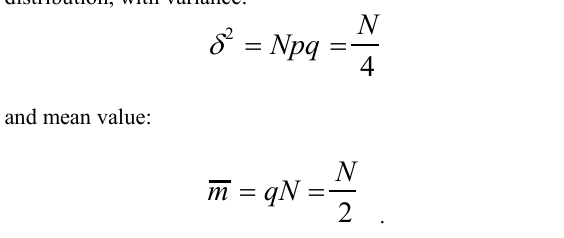
Figure 6. Illustration of the FNR for Gaussian distribution.